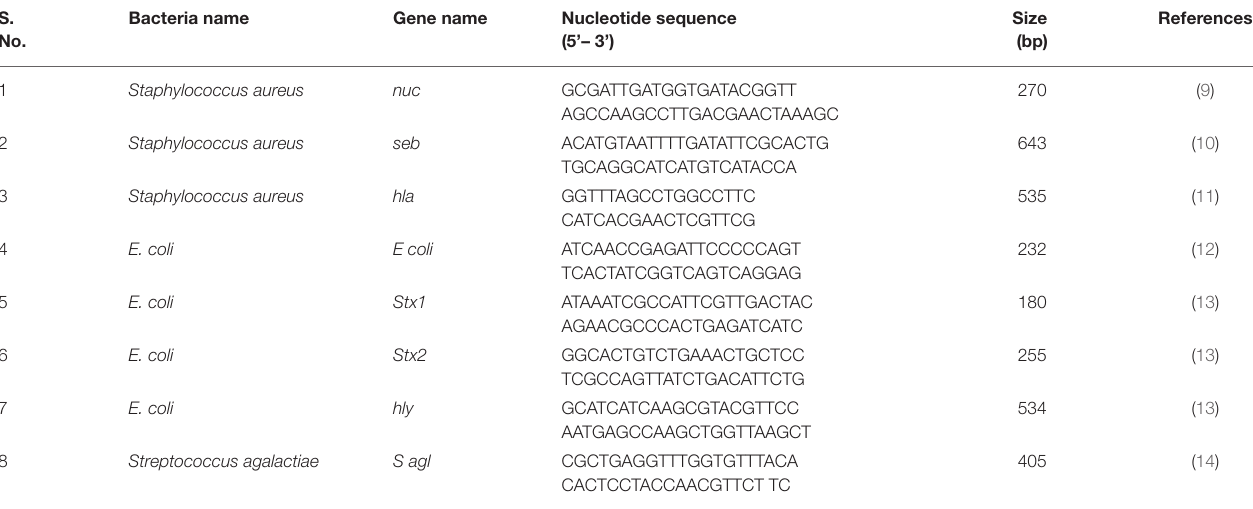
TABLE 1 | Nucleotide sequences of the bacteria-specific or their toxic genes for PCR amplification. S. No.